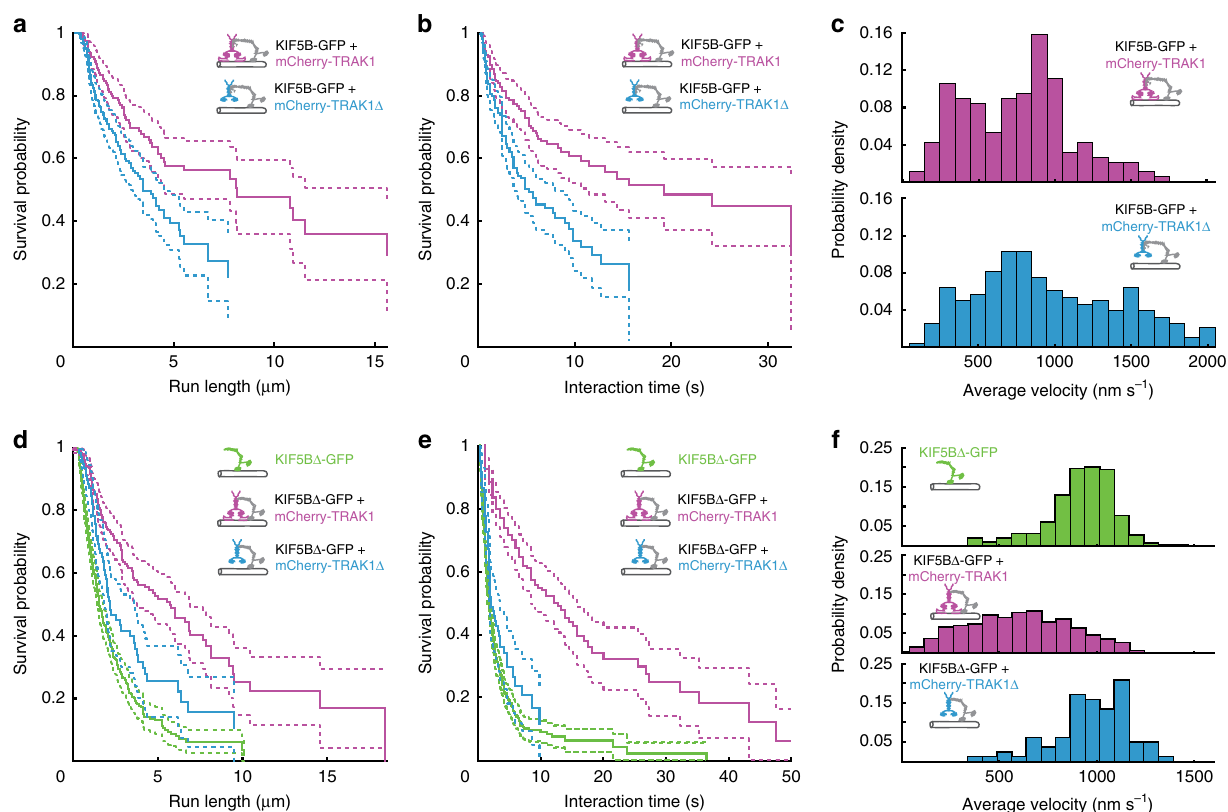
Fig. 2 TRAK1 increases KIF5B processivity. a , b Survival probability (Kaplan – Meier estimation) of the run length and interaction time, respectively, of KIF5B-GFP in presence of mCherry-TRAK1 (magenta, n = 189 molecules, N = 3 experiments) and mCherry-TRAK1 Δ (cyan, n = 282 molecules, N = 3 experiments) ( p = 0.0003 and p < 10 − 4 , respectively). c Histograms of the average velocities of KIF5B-GFP in presence of mCherry-TRAK1 (magenta, n = 189 molecules, N = 3 experiments) and mCherry-TRAK1 Δ (cyan, n = 282 molecules, N = 3 experiments), respectively. d , e Survival probability of the run length and interaction time, respectively, of KIF5B Δ -GFP (green, n = 499 and 534 molecules, respectively, N = 2 experiments), KIF5B Δ -GFP in complex with mCherry-TRAK1 (magenta, n = 222 and 221 molecules, respectively, N = 4 experiments) and KIF5B Δ -GFP in complex with mCherry-TRAK1 Δ (cyan, n = 82, N = 2 experiments). In presence of mCherry-TRAK1, the median run length and interaction time of KIF5B Δ -GFP increased (both p -values < 10 − 4 ). The increase was signi fi cantly less pronounced in presence of mCherry-TRAK1 Δ ( p = 0.0008 and p = 0.0418, respectively). f Histograms of the average velocities of KIF5B Δ -GFP (green, n = 534 molecules, N = 2 experiments), KIF5B Δ -GFP in presence of mCherry-TRAK1 (magenta, n = 487 molecules, N = 4 experiments) and KIF5B Δ -GFP in presence of mCherry-TRAK1 Δ (cyan, n = 82 molecules, N = 2 experiments). The velocity of KIF5B Δ -GFP decreased only in presence of mCherry-TRAK1 but not in presence of mCherry-TRAK1 Δ . See also Supplementary Fig. 2. All two-tailed p -values were obtained by a log-rank test. Source data are provided as a Source data fi